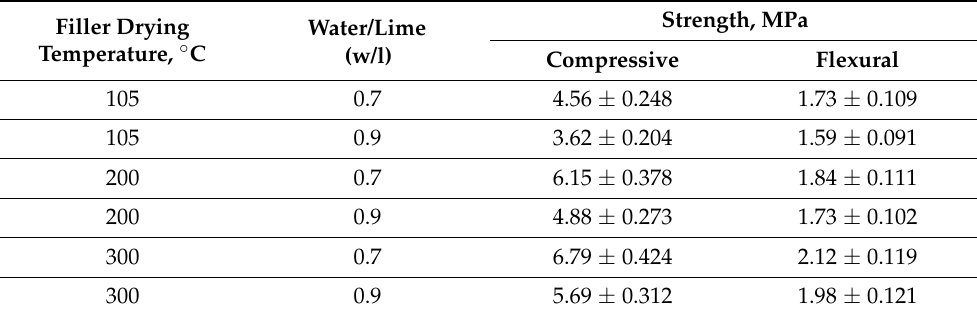
Table 8. Strength of the lime compositions. Filler Drying